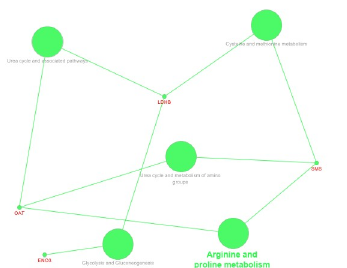
Figure 6. Visualisation of the functionally grouped gene ontology and protein interaction networks of DEPs in porcine endometrium. Comparison of the peri-implantation periods of (12D and 16D) pregnancy based on pathway’s enrichment significance analysis by Cytoscape ClueGo TM . The nodes’ size reflects the pathway’s enrichment